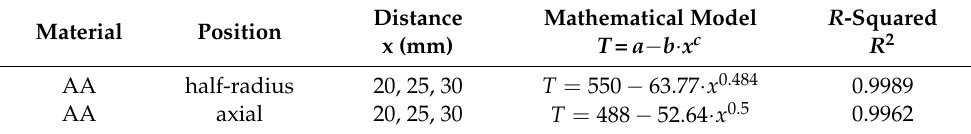
Table 5. Mathematical models for predicted peak temperature for the friction welding